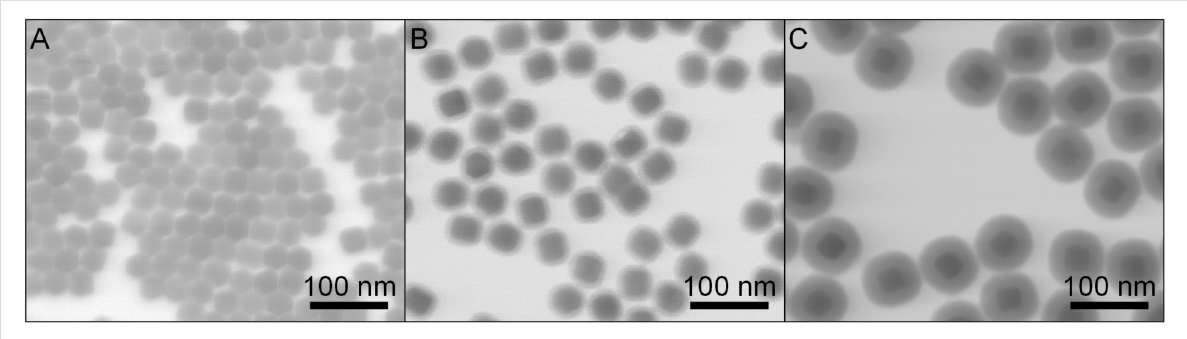
Figure 1: STEM image of (A) oleate-coated UCNPs (NaYF 4 : 18% Yb, 2% Er). (diameter = 33 ± 2 nm), (B) UC@thin (thickness of the silica shell ( t SiO2 ) = 7 ± 2 nm); (C) UC@thick ( t SiO2 = 21 ± 3